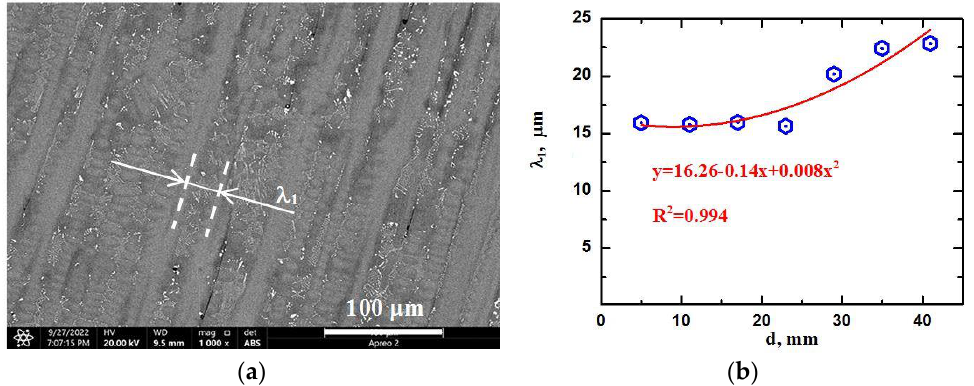
Figure 4. Characteristic SEM image of the dendritic structure of the additive ZhS32 superalloy material ( a ) and the dependence of the average primary dendrite arm spacing λ 1 on the distance to the substrate in the product material ( b ).